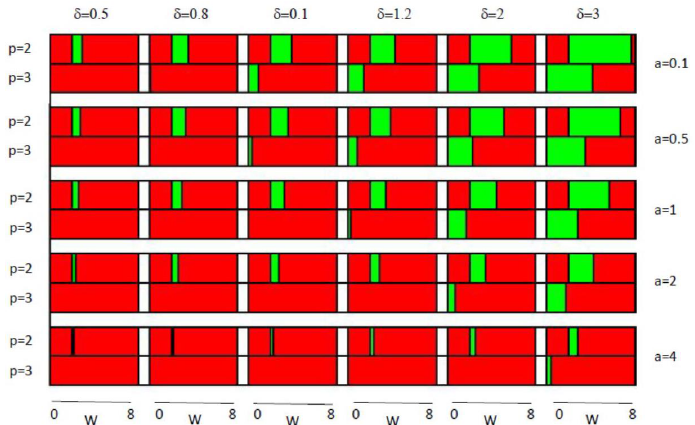
Figure 12. Sign of DU ( W ) for W ∈ ( 0,8 ) : negative (red), positive (green). The first (second) row of each block of two rows corresponds to p = 2 ( p = 3). The white column and row separate blocks for several combinations of a = 0.1,0.5,1,2,4 (row) and δ = 0.5,0.8,1,1.2,2,3